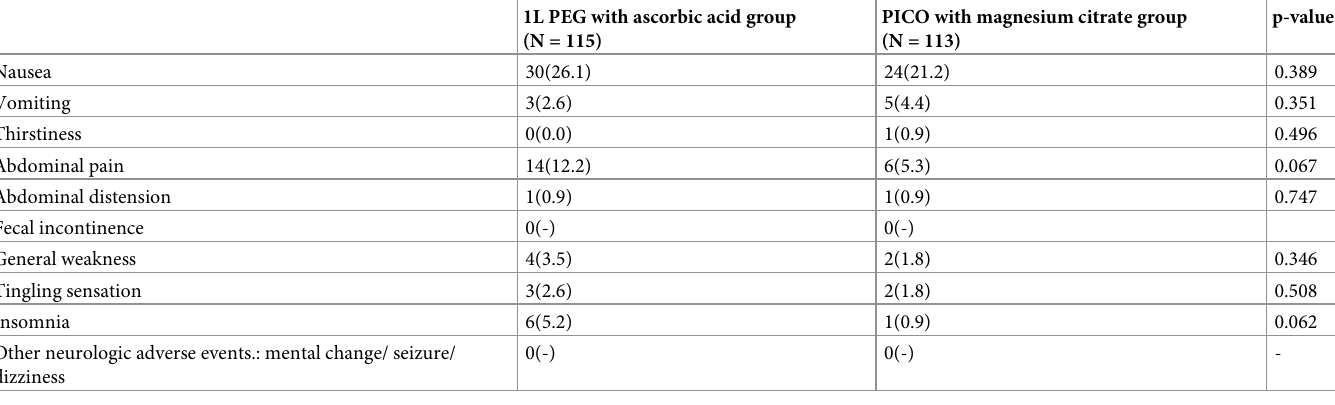
Table 4. Adverse events associated with bowel cleansing